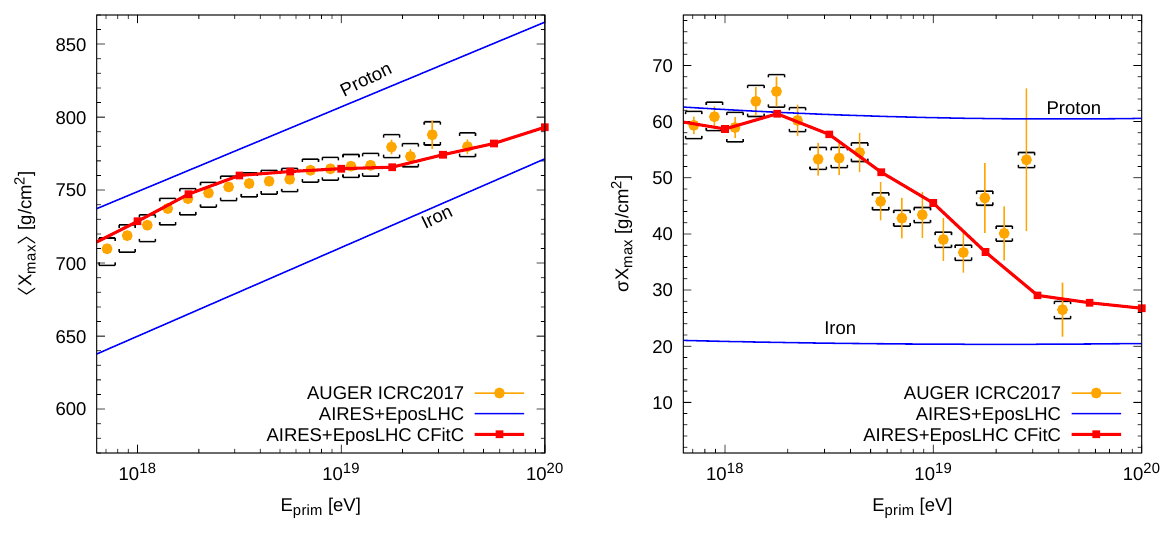
Figure 3. X max and σ X max versus primary energy. The experimental points reproduce the Auger Observatory data published in reference [3]. The error bars (horizontal square brackets) correspond to statistical (systematic) uncertainties. The red curves (labelled CFitC) correspond to simulations with AIRES + EPOS-LHC using an energy dependent combined composition (see text).